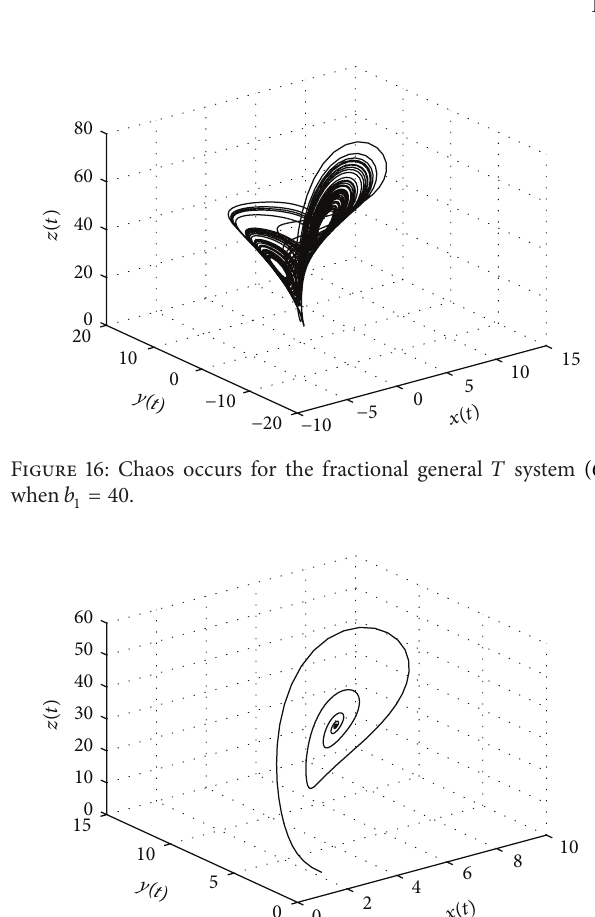
Figure 17: Asymptotic stable solution for the controlled fractional general 𝑇 system (89), when 𝑏 1 =